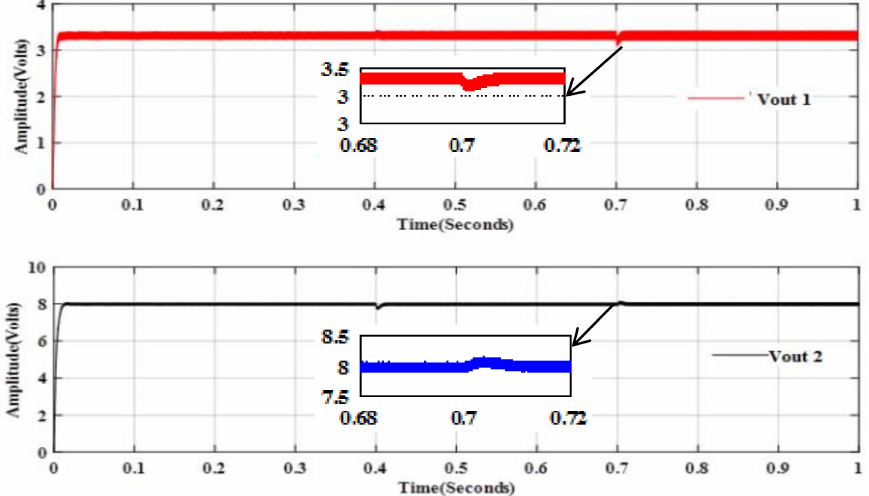
Figure 13. Closed loop response of the DIDO converter with LQR controller with load